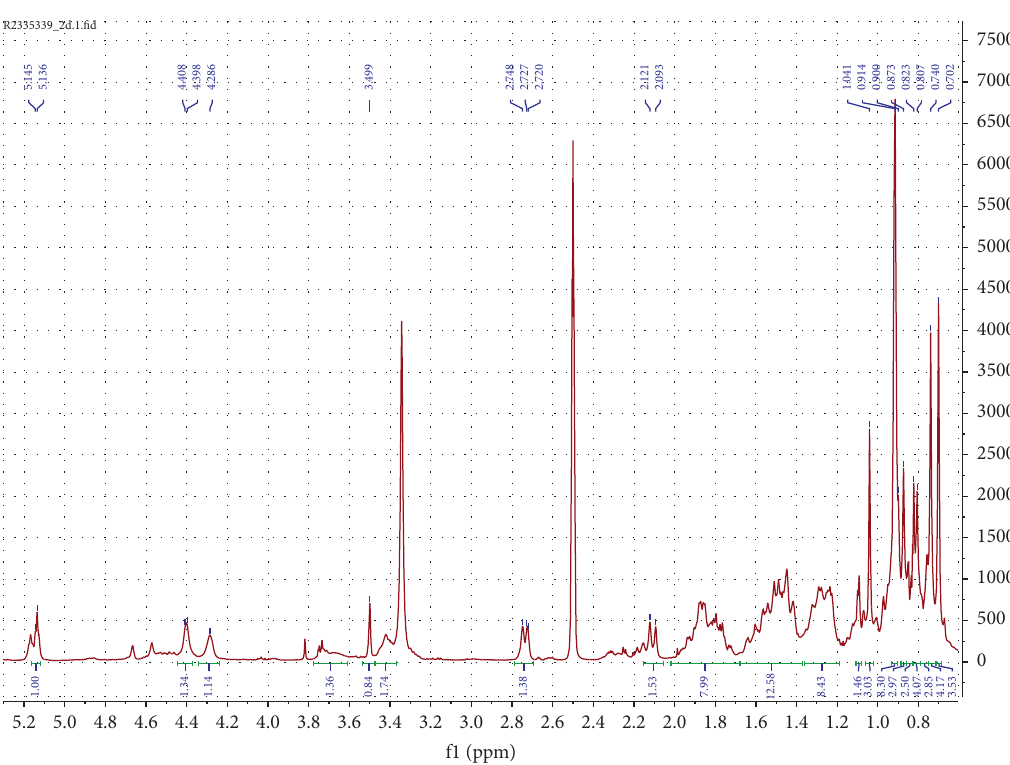
Figure 2: 1 H NMR (DMSO, 400 MHz) spectrum of tormentic acid.